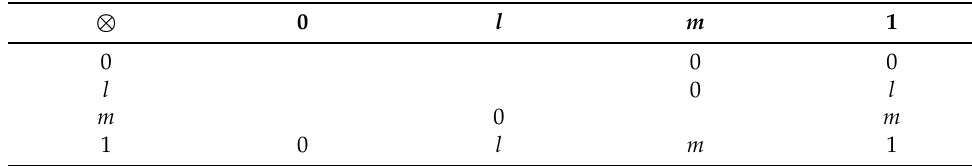
Table 11. The partial operation ⊗ .